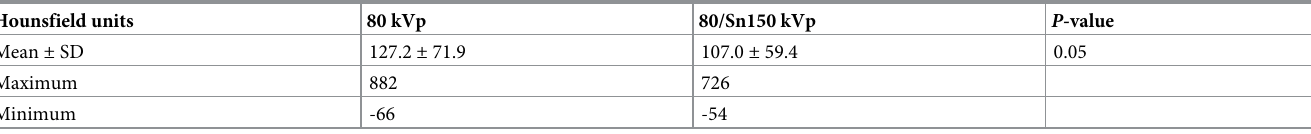
Table 4. Differences between modified line-density profiles within the tumor border.